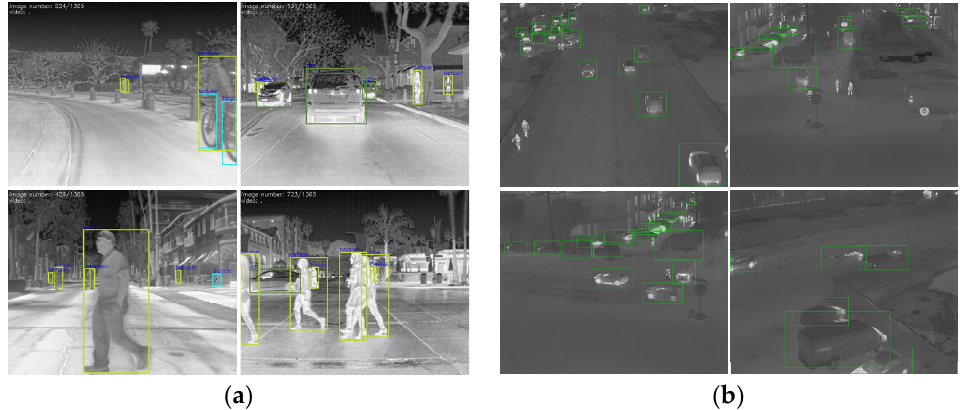
Figure 5. Display of some images in the dataset mentioned in this article. ( a ) some images of FLIR dataset; ( b ) some images of our dataset. dataset; ( b ) some images of our